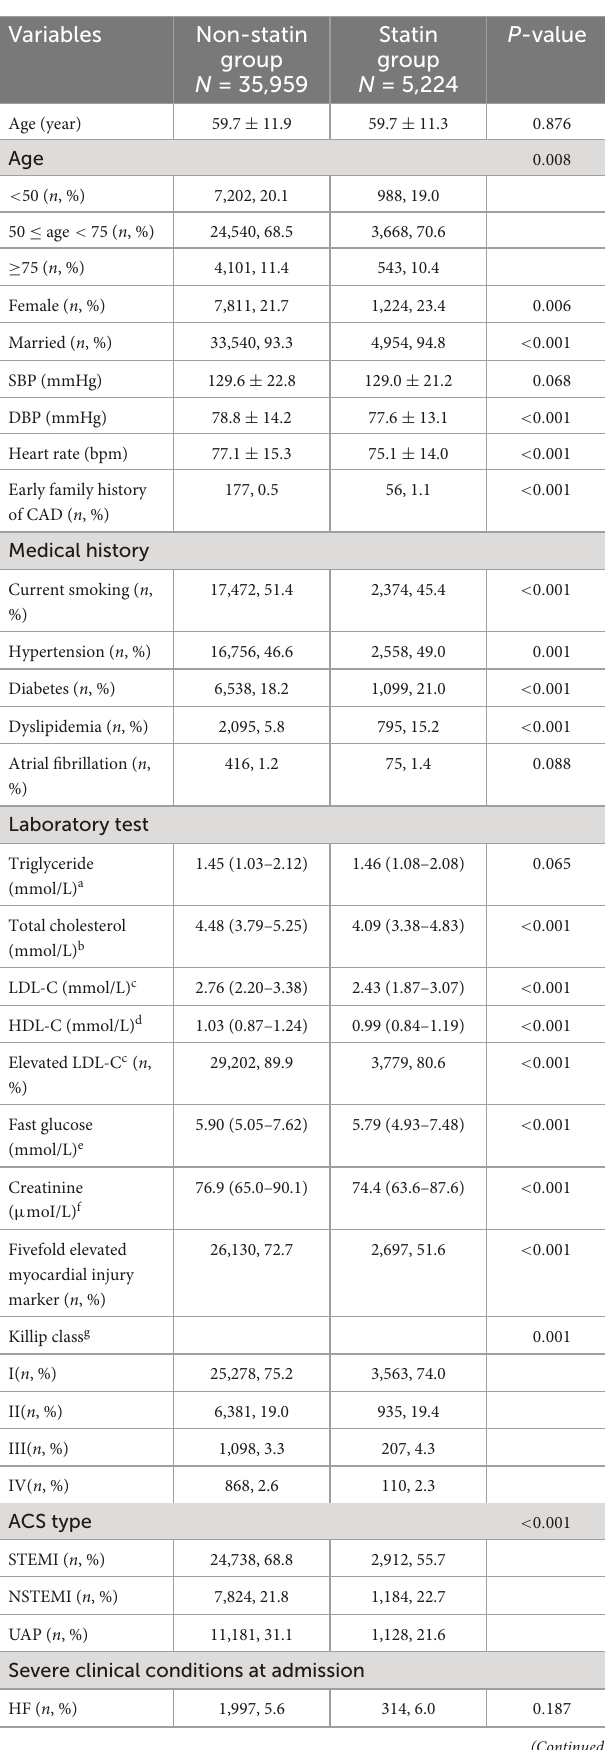
TABLE 1 Clinical characteristics of patients.